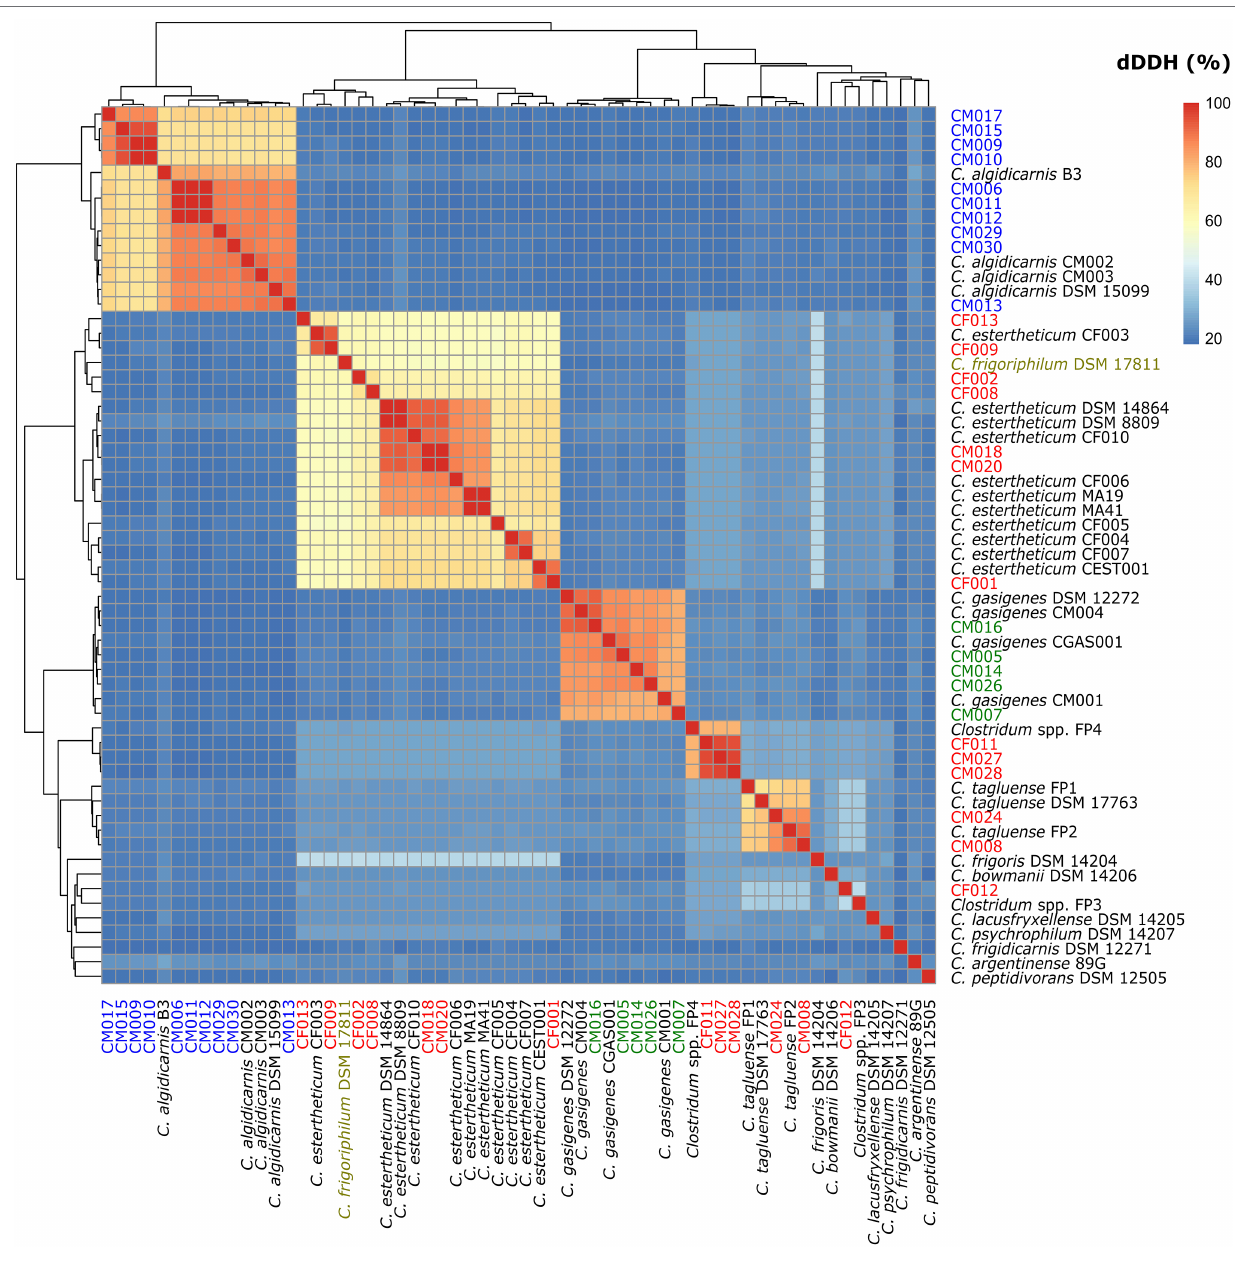
FIGURE 4 | Heat map of digital DNA-DNA hybridization (dDDH) analysis of 28 Clostridium spp. strains isolated from MJS and BFS and 32 representative clostridia strains. Thirteen isolates belonging to the Clostridium estertheticum complex are highlighted in red. Other isolates within species C. algidicarnis (blue text; n = 10) and C. gasigenes (green text; n = 5) are also highlighted. C. frigoriphilum DSM 17811 is highlighted in